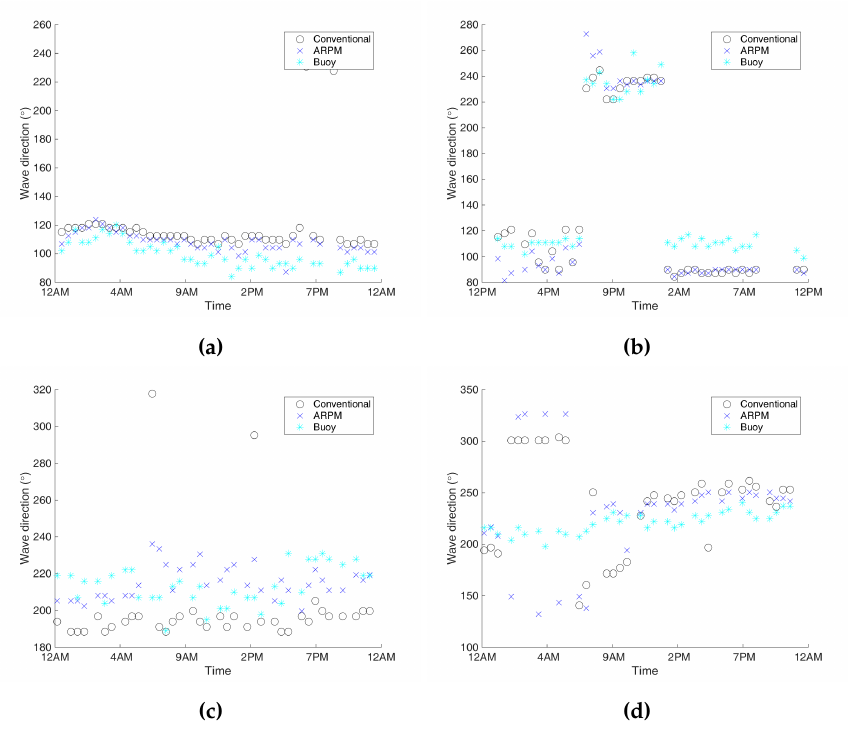
Figure 14. A comparison between the ARPM and the standard method in terms of the peak wave direction. ( a – d ) 27 November, 29 November, 1 December and 3 December